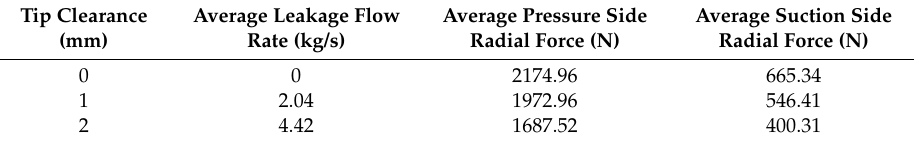
Table 2. Leakage flow and radial force for different tip clearances.